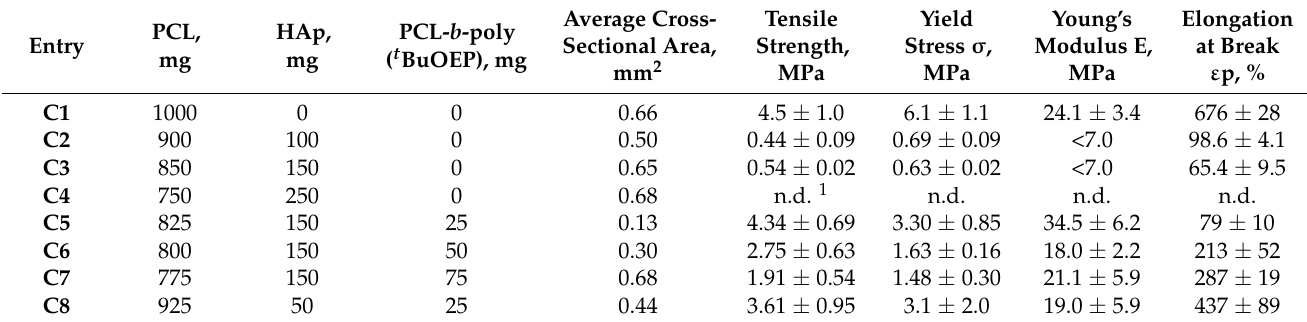
Figure 5. Sedimentation of HAp in the presence (left) and in the absence (right) of PCL- b -PEPA: sedimentation after ( a ) 1 h and ( b ) 2 h; ( c ) stable dispersion and precipitate formed after 8 h. In all ES experiments, we used commercial εCL homopolymer ‘ Polymorphus ’ ( M n = 87.5 kDa, Ð M = 1.46) as a PCL component, and prepared a series of ES films from pure PCL (Table 1, Entry C1 ), dispersions of HAp in PCL solutions with different PCL/HAp ratios (Table 1, Entries C2 – C4 ) and dispersions of HAp, prepared by stirring at 90 °C with different amounts of PCL- b -poly( t BuOEP) (this temperature provides transformation to PCL- b -PEPA) with subsequent addition of PCL (Table 1, Entries C5 – C8 ). Experimental details of the preparation and ES molding of PCL/HAp dispersions are presented in Section 4.3. Table 1. Preparation and properties of ES mats (4 mL HFIP was used in all experiments).